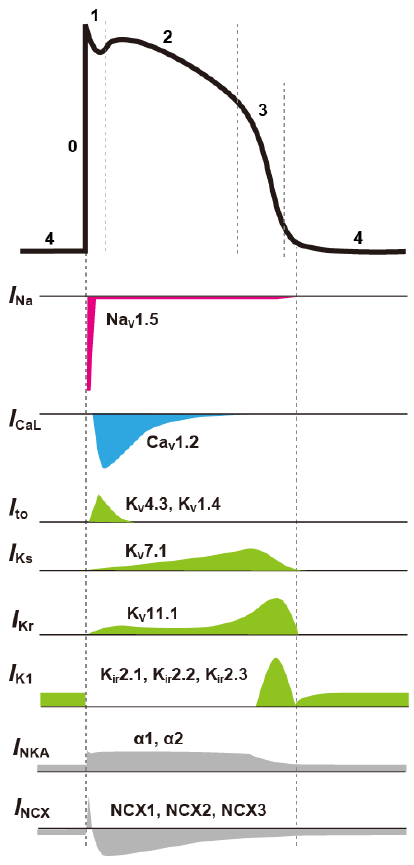
Figure 1. Schematic representation of a typical action potential (AP) in the ventricular myocyte and the respective ion channel currents that contribute to AP formation. It also indicates the major molecules that constitute ion channels and transporters (for the meanings of individual symbols, see text).